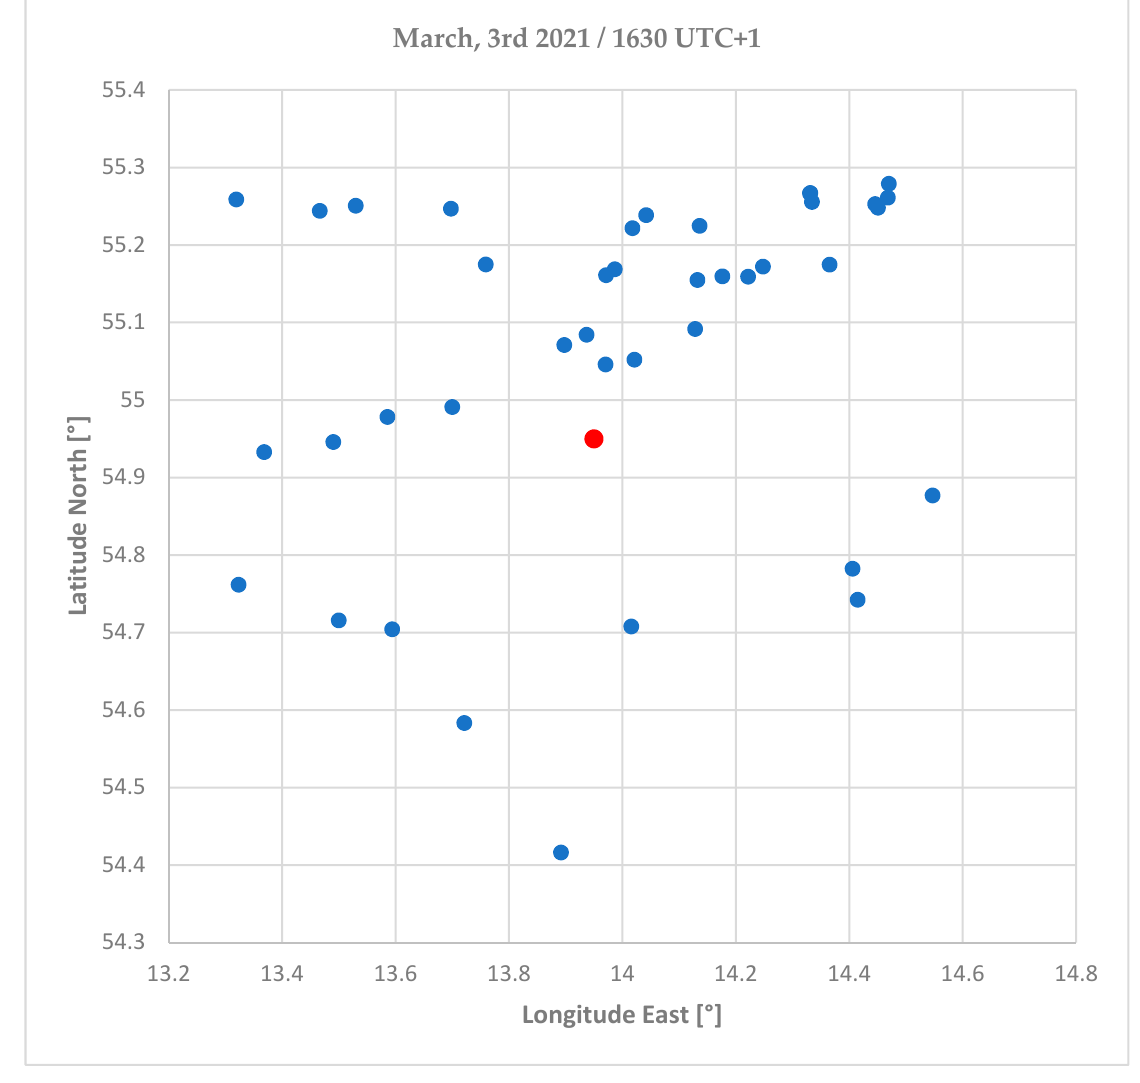
Figure 4. Positions of pre-selected ships, charted (own work).